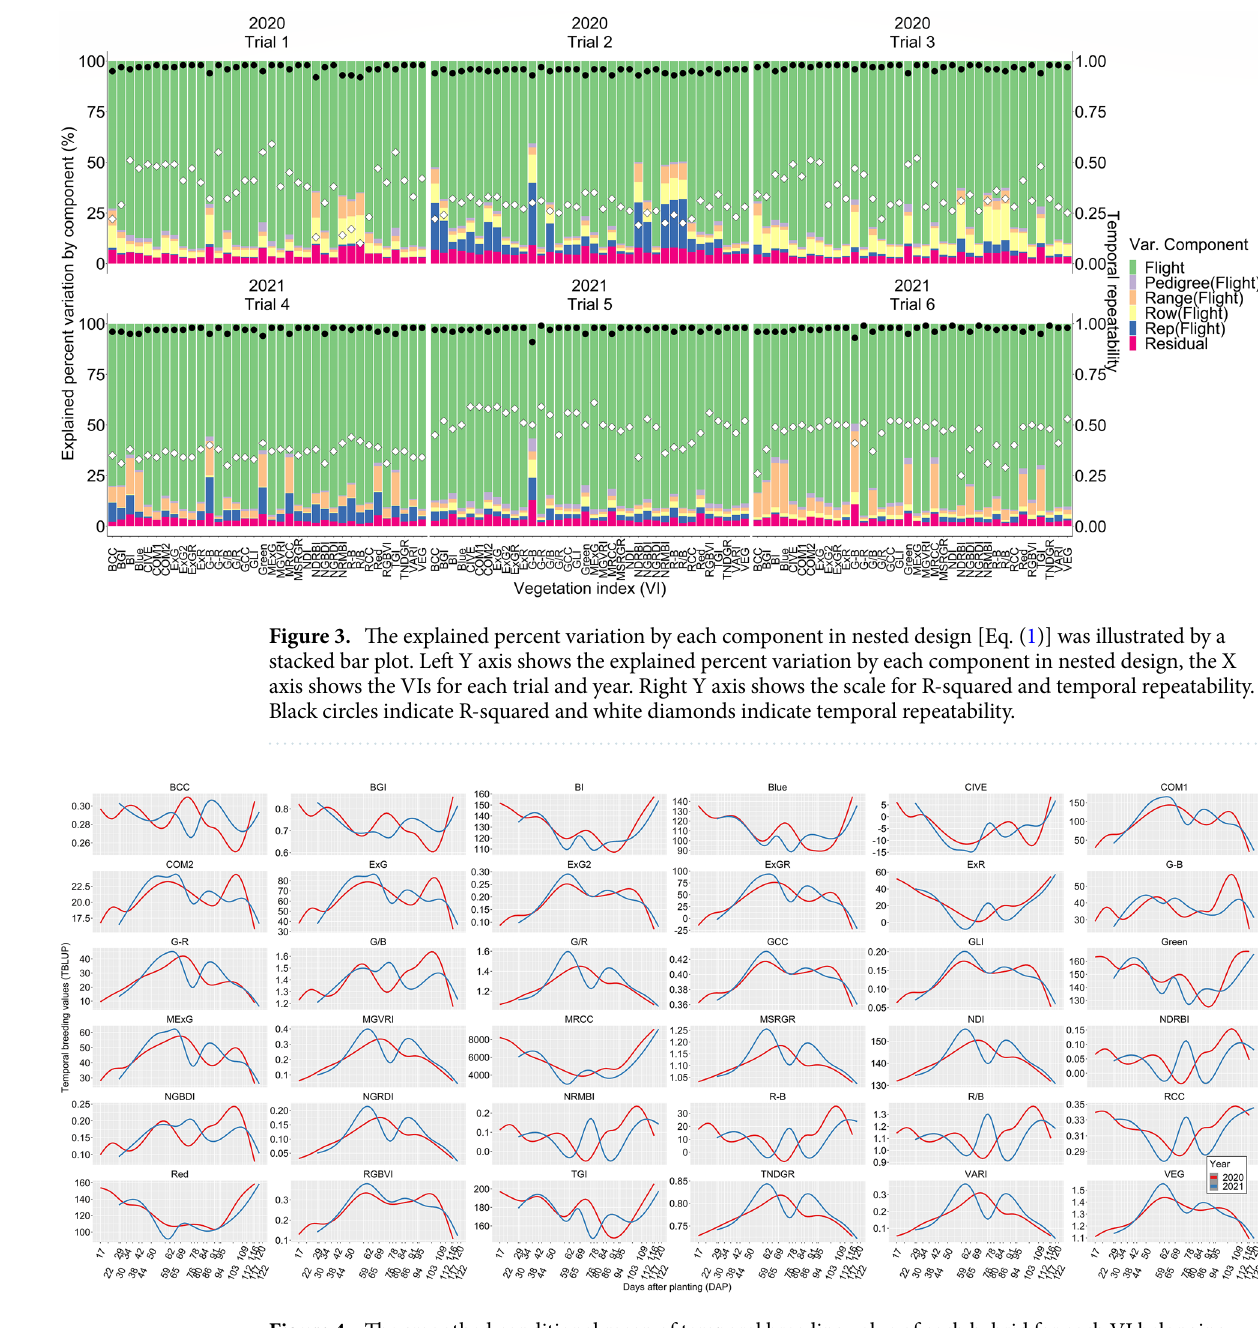
Figure 4. The smoothed conditional mean of temporal breeding value of each hybrid for each VI belonging to 2020 (red lines) and 2021 (blue lines) predicted by hybrid nested within flight component in nested design [Eq.